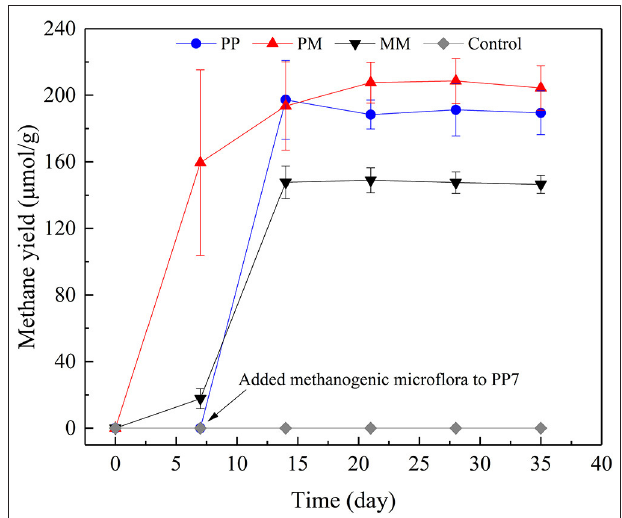
FIGURE 1 | Methane productions from raw coal by methanogenic microflora (MM), from coal treated by PAHs-degrading fungal flora (PF) for 7 days (PP), from raw coal by mixed culture of PF and MM at a ratio of 1:5 (PM), and from raw coal without methanogenic microflora